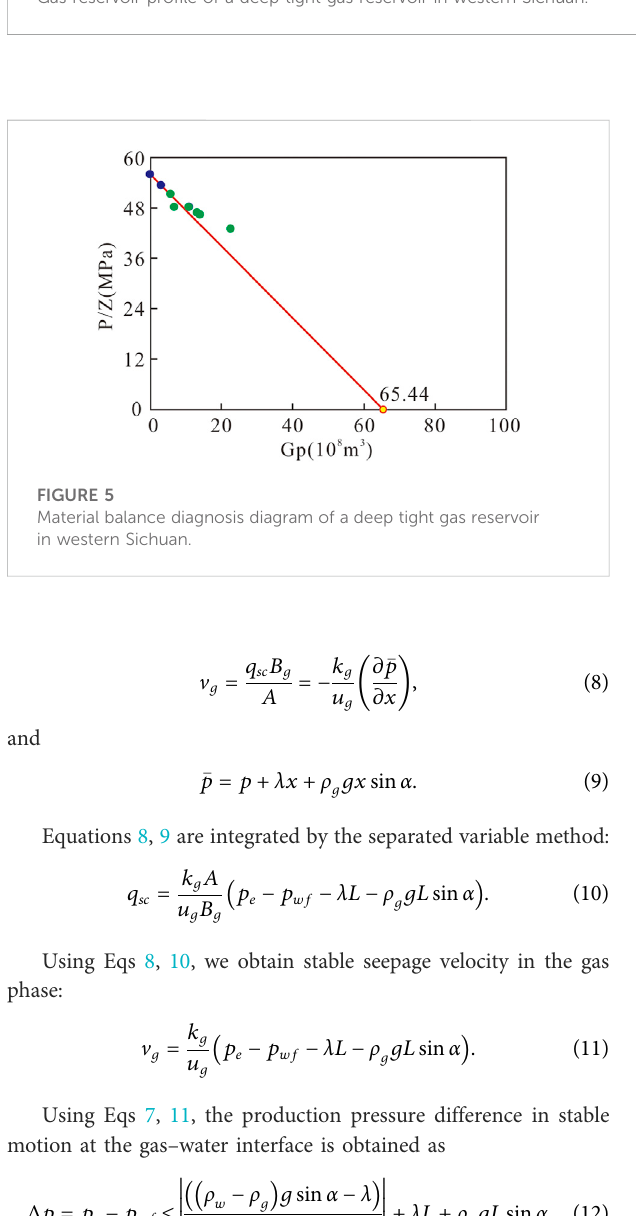
FIGURE 4 Gas reservoir pro fi le of a deep tight gas reservoir in western Sichuan.